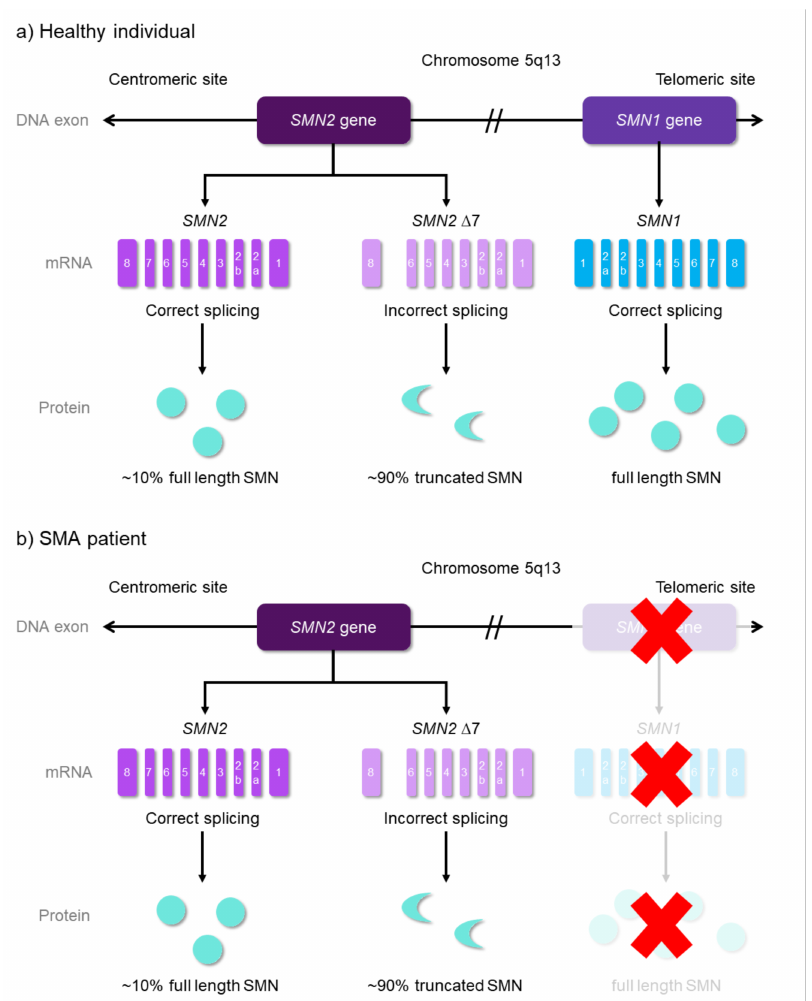
Figure 2. Schematic diagram of human survival motor neuron ( SMN ) gene expression for both healthy individuals and SMA patients. The telomeric SMN1 and centromeric SMN2 genes are identified specifically in the chromosome 5q13 region (long arm of chromosome 5). The SMN1 gene produces all full length SMN (FL-SMN) protein, while the SMN2 gene produces ~10% FL- SMN protein and ~90% truncated SMN protein ( SMN ∆ 7) due to incorrect splicing. ( a ) In healthy individuals, both SMN genes are present. ( b ) In SMA patients, the absence of the SMN1 gene, due to mutations, causes no FL-SMN protein production from SMN1 (This condition is indicated as red ‘X’). The production solely depends on the SMN2 gene, resulting insufficient